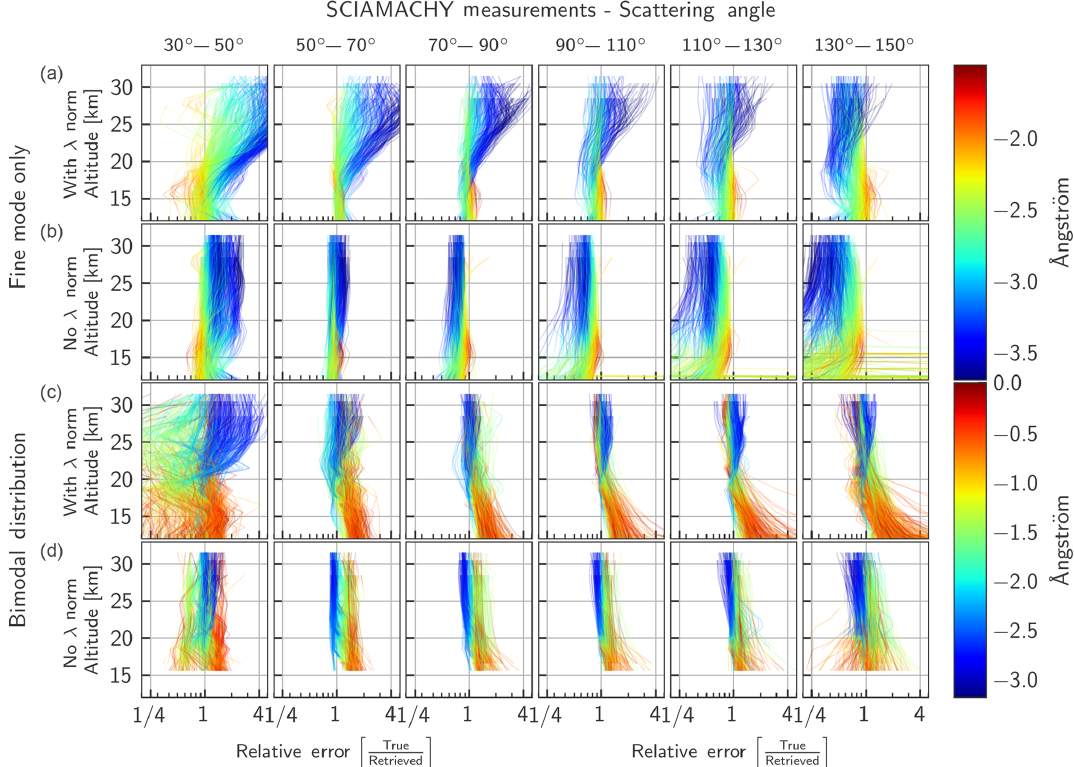
Figure 7. Error in the retrieved USask extinction for the simulated SCIAMACHY measurements grouped by the scattering angle for four different cases. The top two rows show results when only a fine mode of aerosols are present; the bottom two rows have both a fine and coarse mode. In both cases retrievals are done with a short wavelength normalization ( a and c ) and without ( b and d ). The colour of the lines indicates the Ångström coefficient.